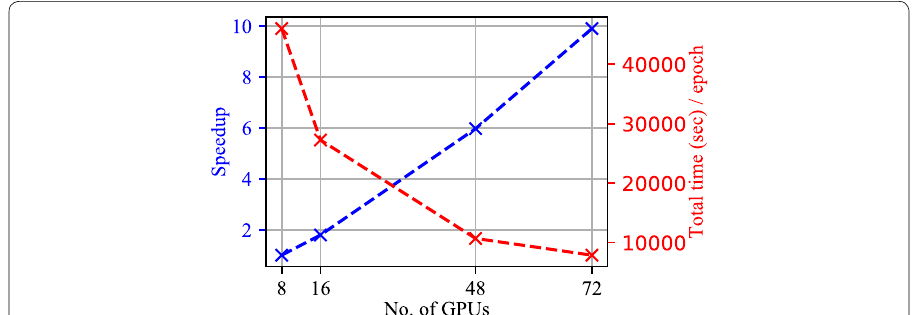
Fig. 3 Gravitational Wave Astrophysics with the XSEDE Bridges-AI Cluster As Fig. 2, but now using the entire Bridges-AI cluster at the Pittsburgh Supercomputing Center. In this case, we reduce the training stage to 38 hours using 72 V100 GPUs